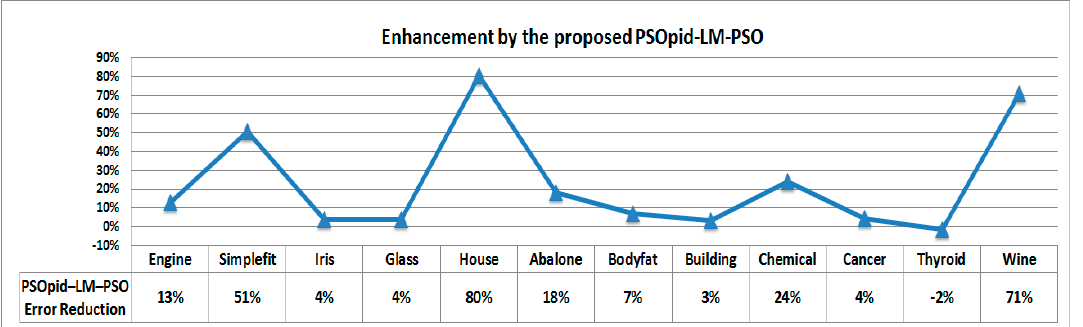
Figure 9. Performance test using a sample dataset.